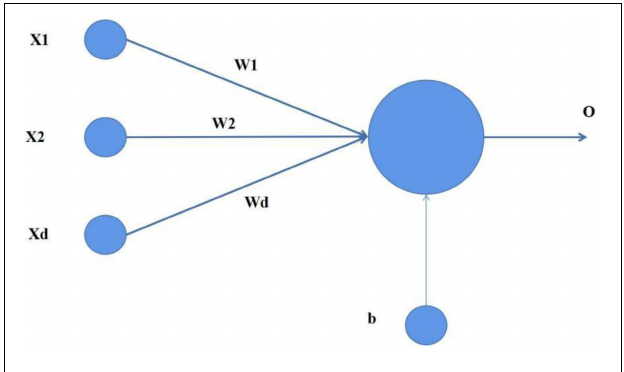
FIGURE 2 | Perceptron.